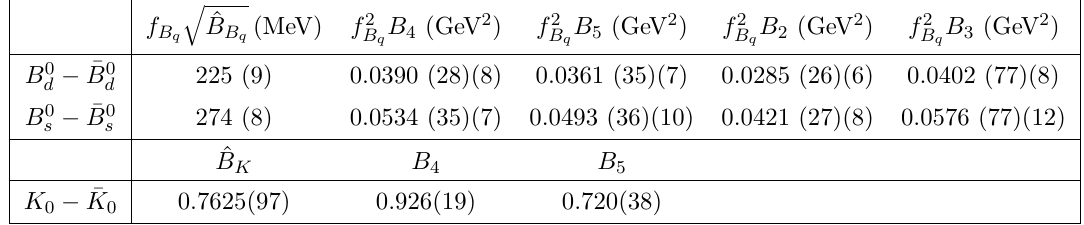
¯ ¯ ¯ Table 2 . Relevant bag parameters for B q − B q oscillations and K 0 − K 0 oscillations. For B q − B q oscillations we use the RG-invariant definition, ˆ B [49], for the SM operator, while the bag B q parameter for the LR model are given in the MS scheme, at the renormalization scale µ = m [136]. b ¯ ˆ For K K 0 oscillations, B K is RG-invariant [49], while B 4 and B 5 are given in the MS scheme, at 0 − µ = 3 GeV. We use the N f = 2 + 1 averages reported in ref.